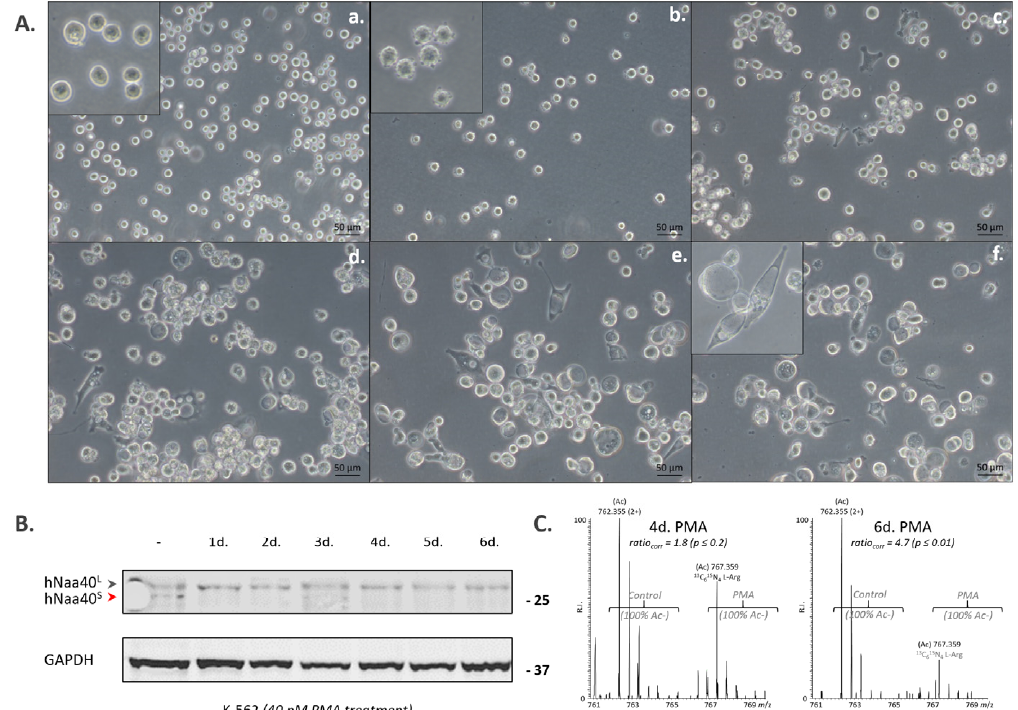
Figure 2. Differentiation of K-562 cells into megakaryocytes induces specific down-regulation of hNaa40 S . ( A ) Morphology of phorbol 12-myristate 13-acetate (PMA) differentiated K-562 cells. Control K-562 cells ( a ), K-562 cells treated with PMA (40 nM) for 5 h, 1 day (d.), 2 d., 3 d. and 4 d. respectively ( b – f ) shows hallmarks of megakaryocytic differentiation upon PMA treatment. Images are annotated with a 50 µ m scale bar. ( B , C ) Expression profiling of endogenous hNaa40p proteoforms at various time points of PMA treatment indicates specific down-regulation of hNaa40 S in PMA-differentiated K-562 cells by Western blot analysis (with GAPDH ((Glyceraldehyde-3-phosphate dehydrogenase), 36 kDa) serving as loading control) ( B ), and following the identification by N-terminal proteomics ( C ). Here, composite MS spectra of the Nt-peptide originating from hNaa40 S (MDAVCAKVDAANR) (see also Figure 1) in the control (light L-Arg SILAC (stable isotope-labeling by amino acids in cell culture) label) and 4 and 6 days PMA treated setups (heavy 13 C 615 N 4 L-Arg SILAC label) are shown. In both setups, in vitro 3 C 2 D 3 -acetylation was performed at the protein level in combination with differential L-Arg SILAC labeling [24] which allows for the calculation of the extent of Nt-acetylation as well as the relative quantification of Nt- peptide abundancy [25,26]. Overall, the N-terminus of hNaa40 S was fully Nt-acetylated in all setups analyzed and the relative concentration of hNaa40 S lowered after 4 d. ( p ≤ 0.2) and 6 d. following PMA treatment ( p ≤